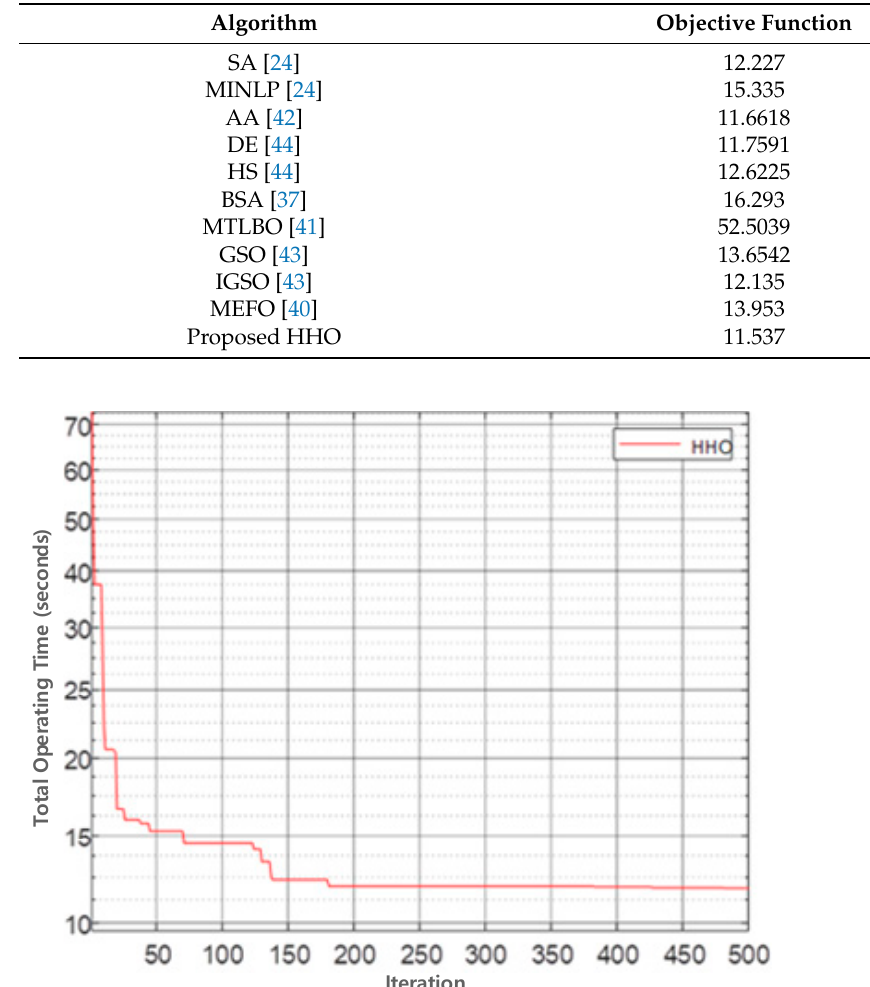
Figure 10. Convergence characteristics of HHO for a 15-bus system.